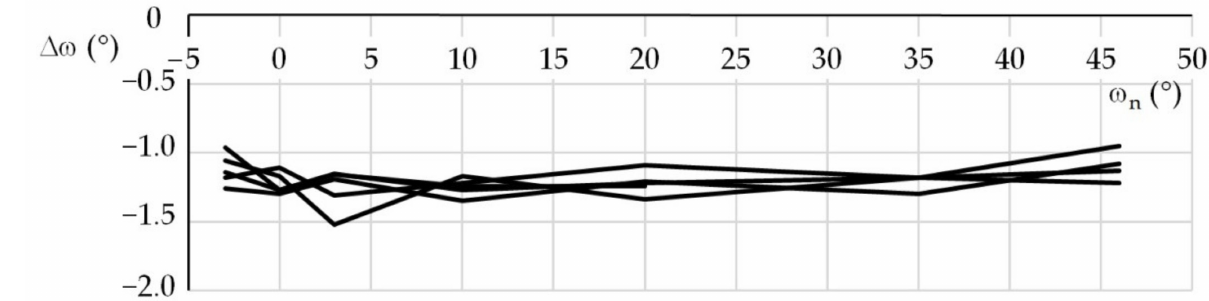
Figure 5. Azimuth errors; first test, ψ n = 20 ◦